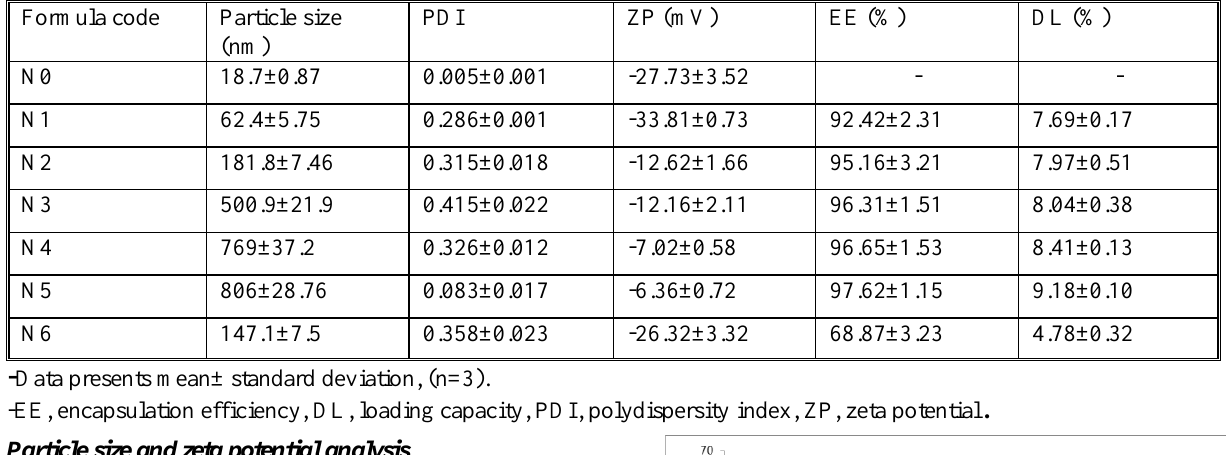
Table 2. Evaluation parameters of different DE-NLCs Formula code